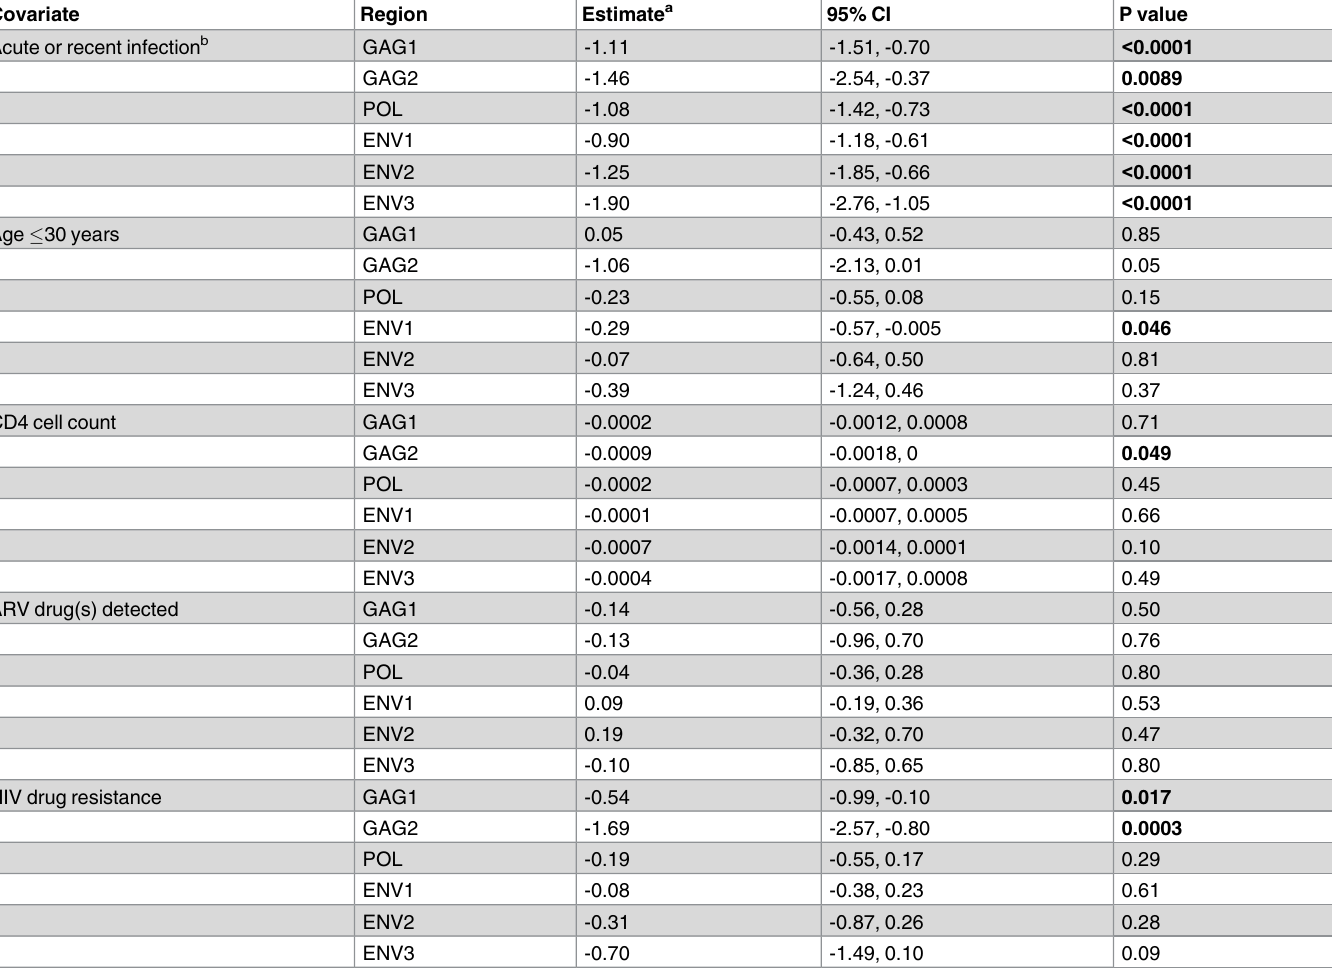
Multivariate analysis was performed separately for each HRM region using the covariates listed; p -values < 0.05 are bolded. Abbreviations: CI: confidence interval; ARV: antiretroviral. a The estimate shows the difference in median HRM score for each factor after adjusting for covariates. b Acute or recent infection at study enrollment, compared to non-recent infection at study